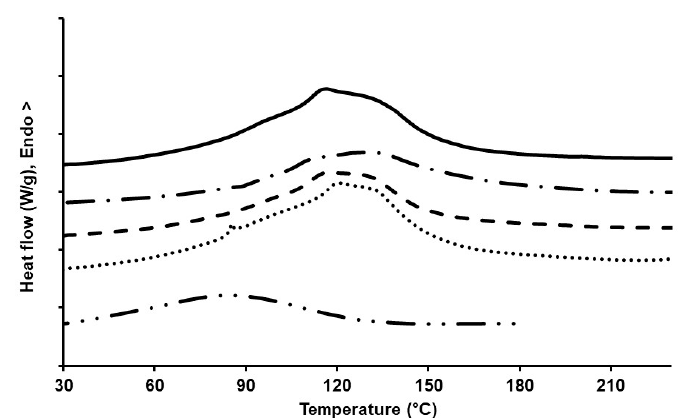
Figure 3. DSC curves of PAN/BL blends with different concentrations of BL and a reference curve for BL; ▬ PAN; ▬ ▪ PAN-10%wt BL; ▬ ▬ PAN-20%wt BL; ▪▪▪ PAN-30%wt BL; ▬ ▪▪ BL.